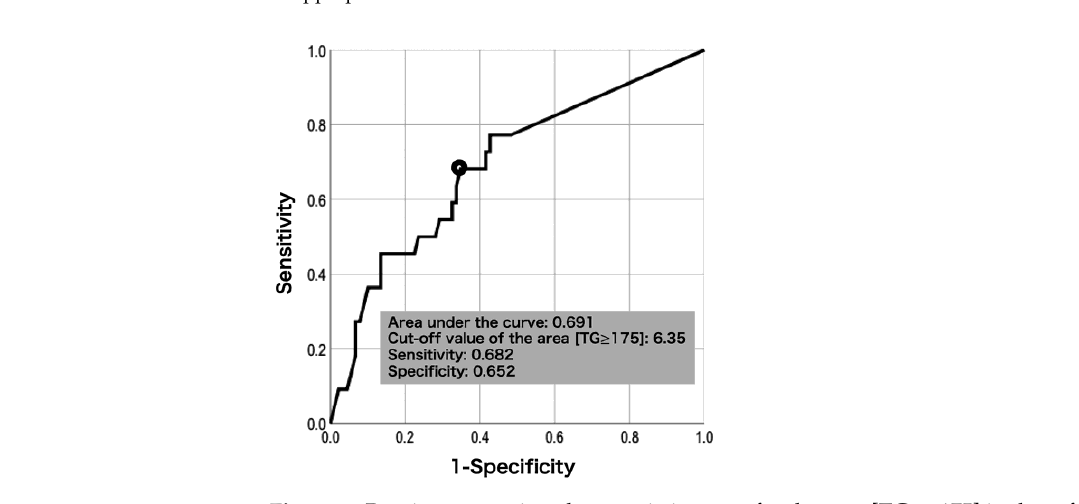
Figure 1. Receiver operating characteristic curve for the area [TG ≥ 175] in the reference population by carotid stenosis progression. by carotid stenosis